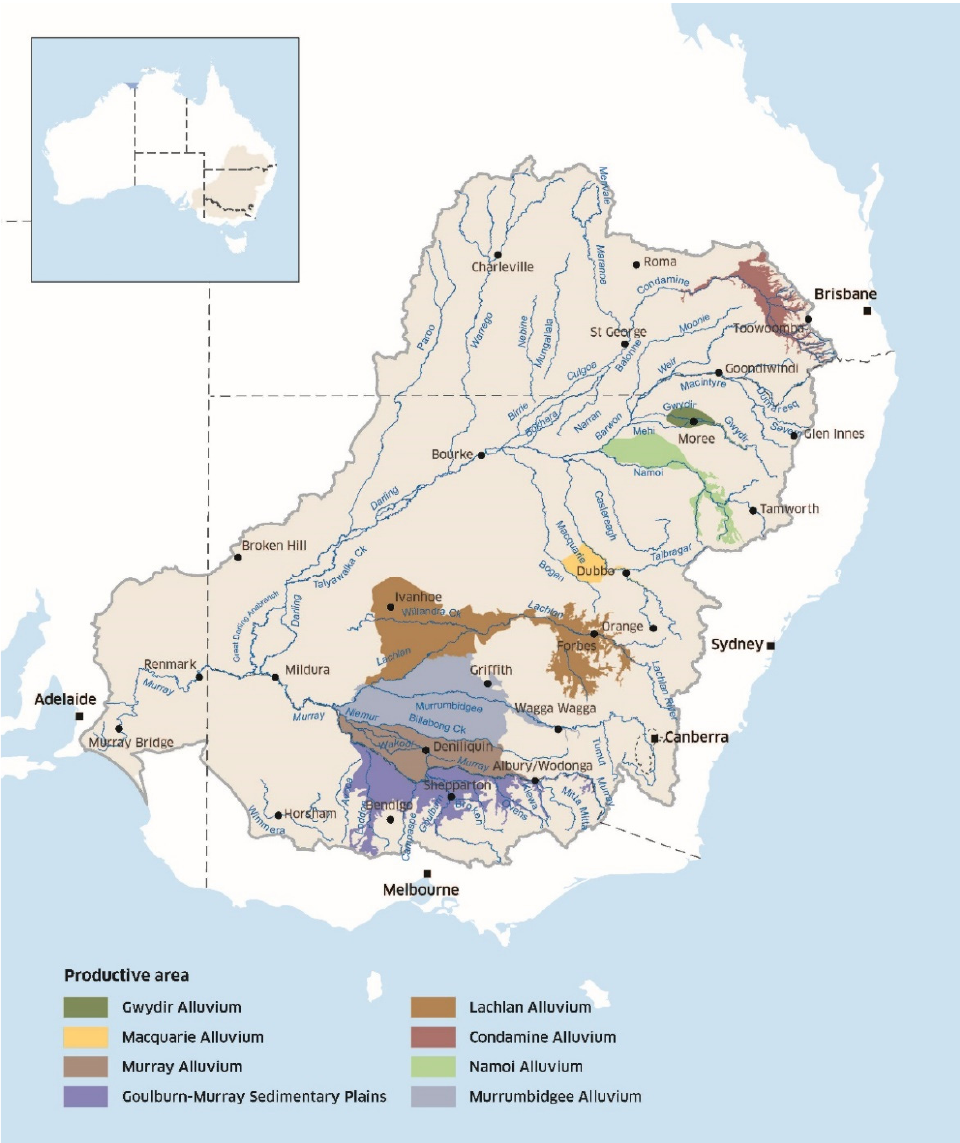
Figure 1. Map of the Murray-Darling Basin showing the alluvial groundwater systems (Source: MDBA). The other priority units include EMLR (east of Adelaide), MGL (south of Renmark), GMH (north of Melbourne and UCB (south-east of Toowoomba). The states containing Adelaide, Melbourne, Sydney and Brisbane are respectively South Australia, Victoria, New South Wales and Queensland.